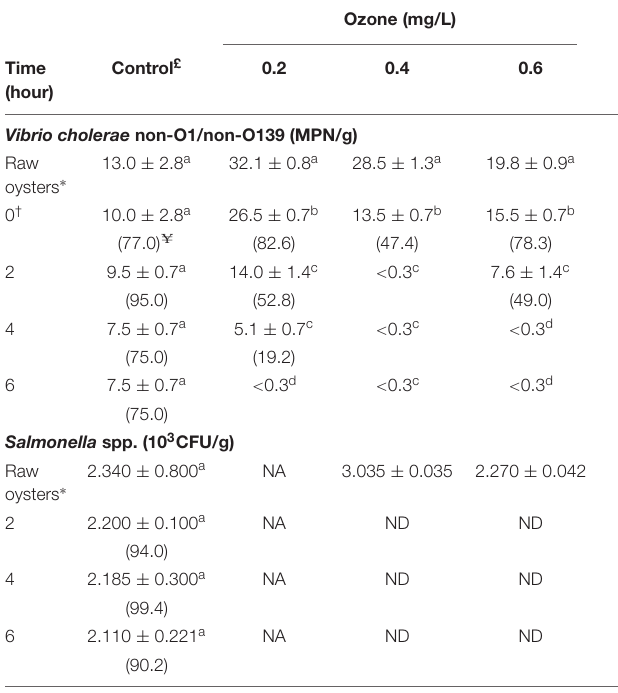
TABLE 1 | Retention rates and changes in Fecal coliforms and Escherichia coli levels in naturally contaminated American oyster ( Crassostrea virginica ) depurated with ozonated seawater.